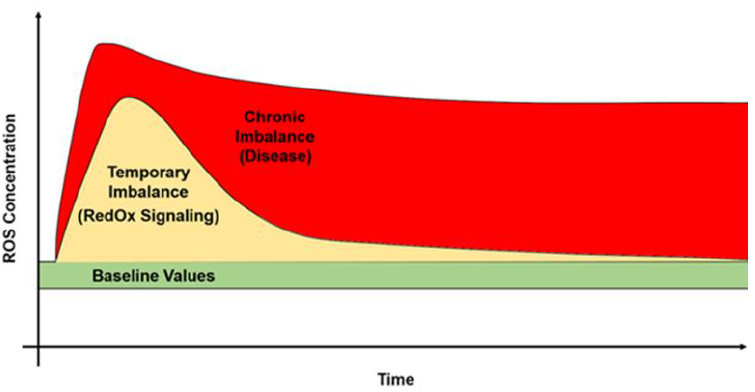
Figure 3. ROS are physiologically produced at low concentration (baseline values, green). ROS have either beneficial effects at middle-low concentration for a short time (orange) or harmful effects at higher concentration for a prolonged time (red).